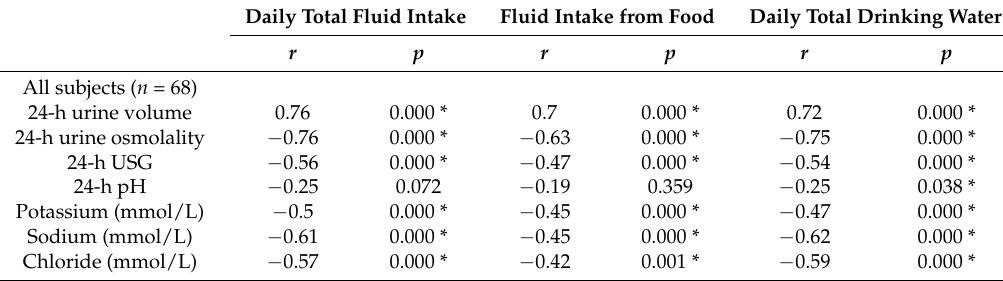
Table 5. Correlations between fluid intake and 24-h urinary biomarkers.